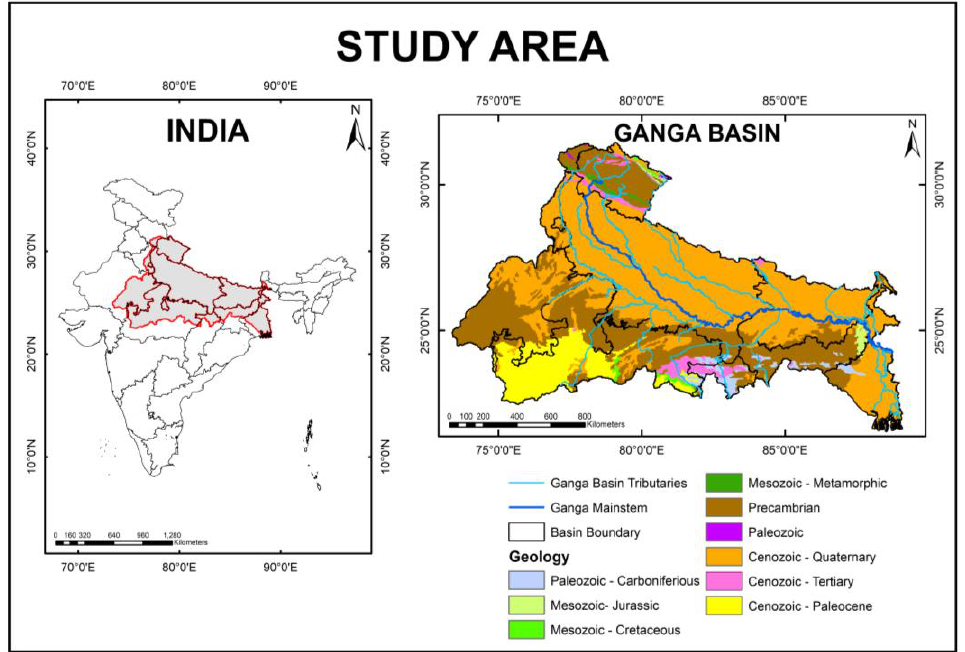
Figure 1. Study area — Ganga Basin, India [34].